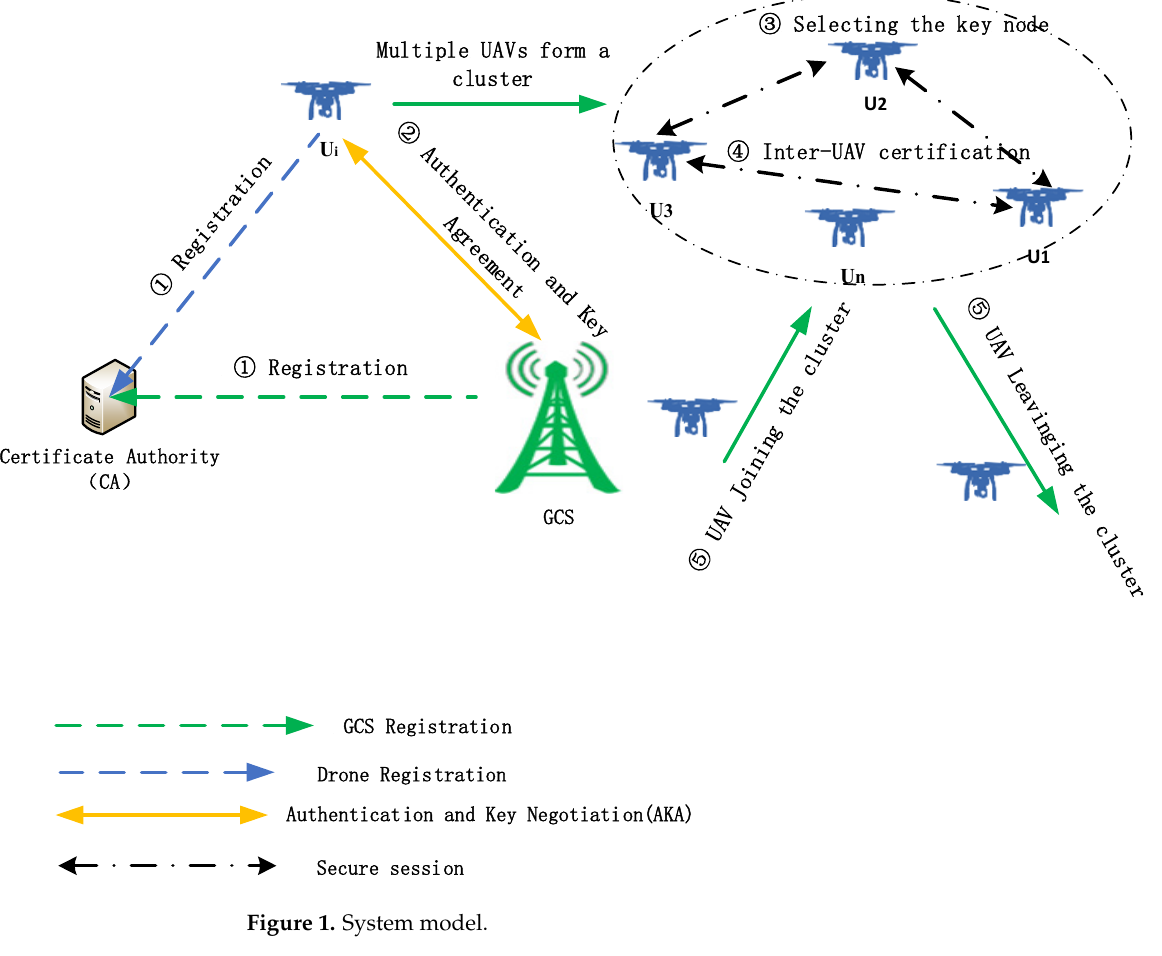
Figure 1. System